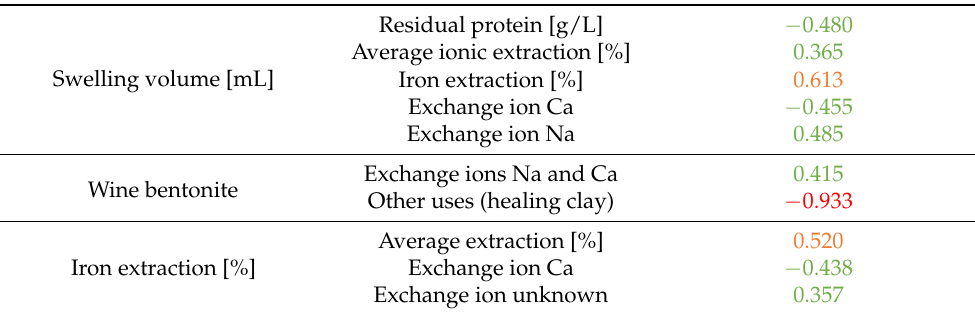
Table 1. Summary of correlation coefficients identified in this